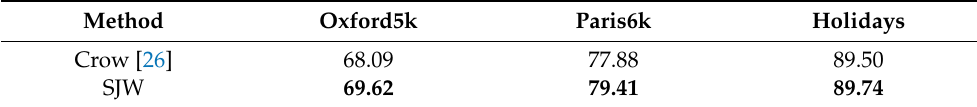
Table 3. Performance (mAP) comparison of cross-dimensional weighting (Crow) [26] and saliency joint weighting (SJW) on the Paris6k, Oxford5k, and Holidays data sets. The best result is highlighted in bold. Method Oxford5k Paris6k Holidays